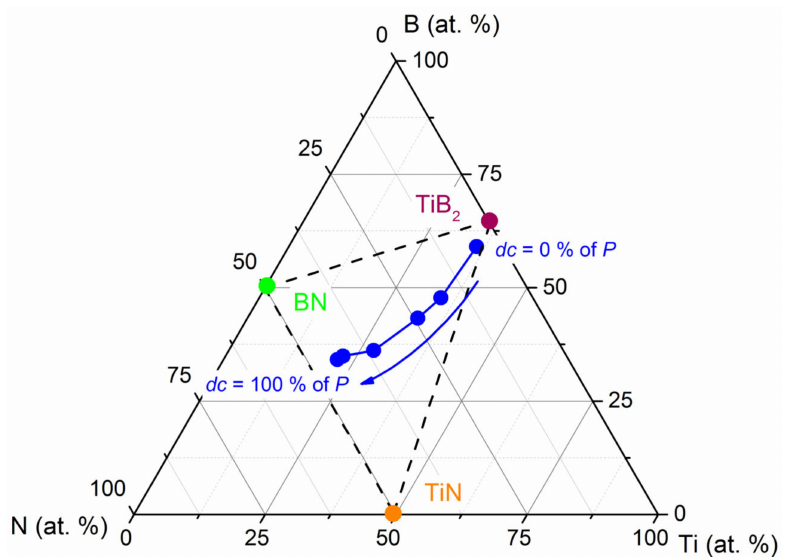
Figure 4. The composition of Ti-B-N films (blue symbols) sputter-deposited by pulsing the nitrogen gas from dc = 0 to 100% of the pulsing period of P = 10 s within a ternary phase diagram. The positions of TiB 2 , TiN and BN stoichiometric compounds are indicated, as well as quasi-binary tie lines between the individual compounds (dashed